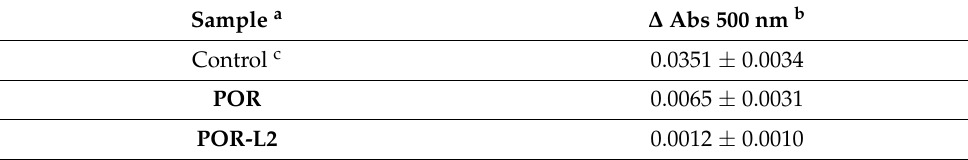
Table 4. Observed absorbance changes obtained for the tested